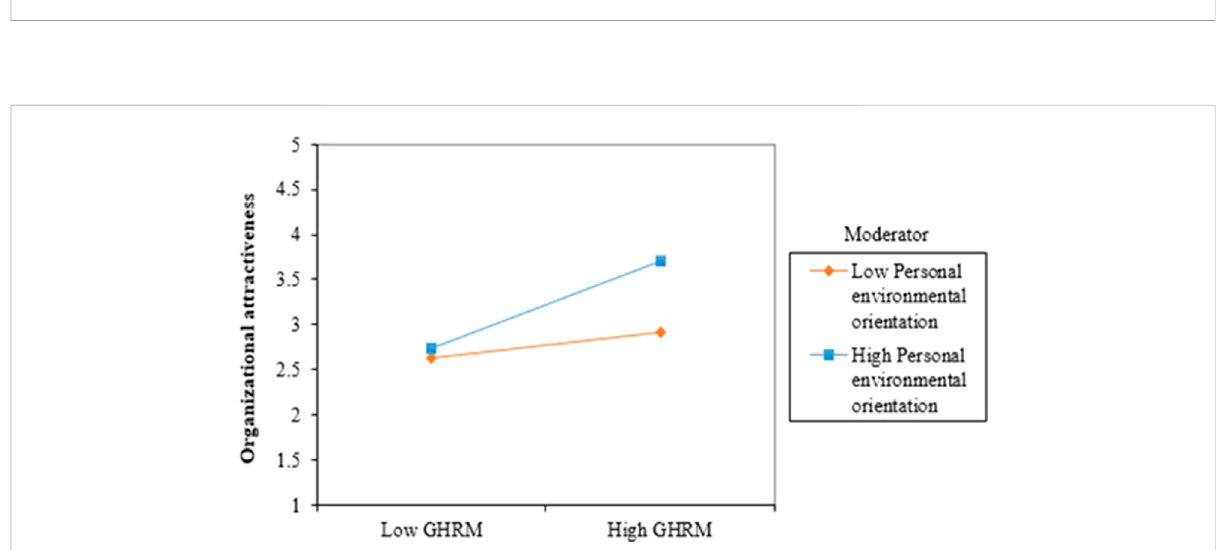
FIGURE 4 Moderation effect of green culture on the link between GHRM and OA.